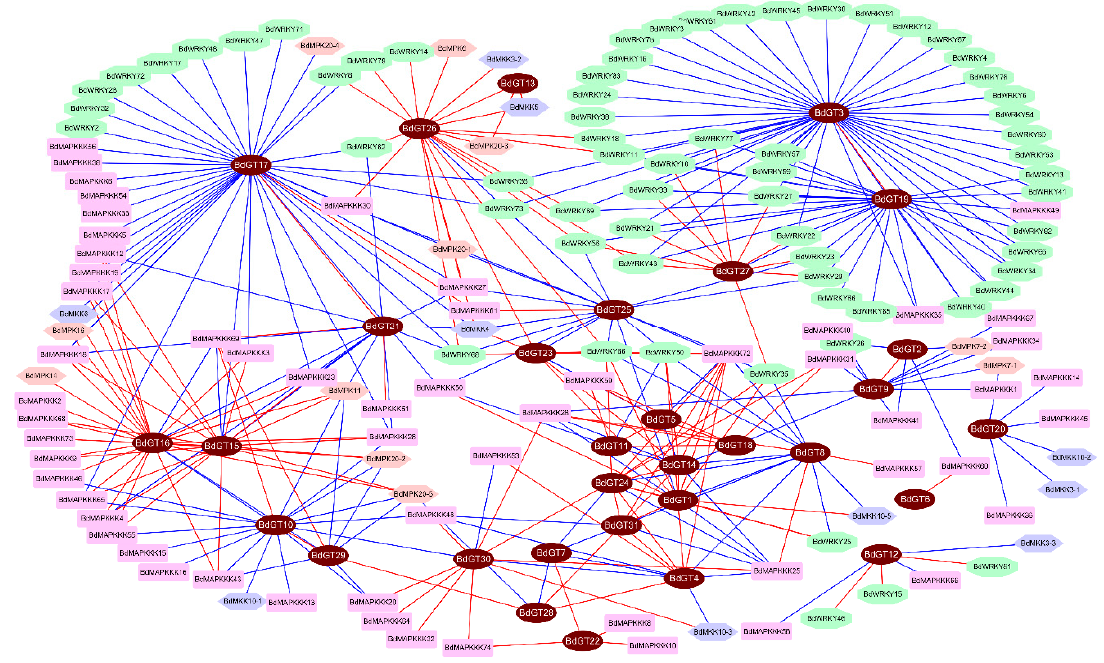
Figure 8. Regulatory networks of GT genes. Co-expression regulatory network among BdGT , BdWRKY , and BdMAPK cascade genes upon different stress treatments based on the Pearson correlation coefficients of the relative expression of genes.